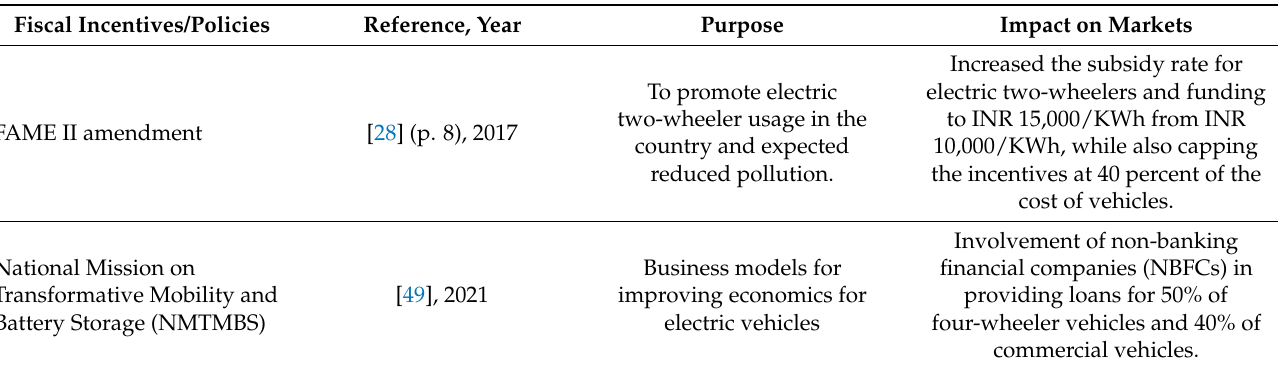
Table 1. Financial incentives and its impact on EV